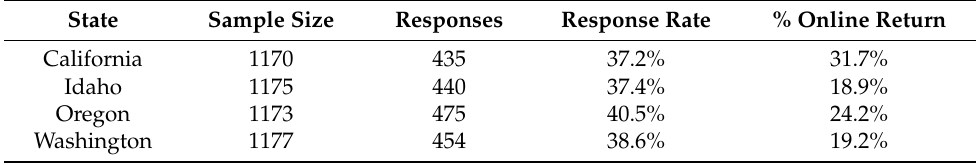
Table 1. Survey Response Rates.